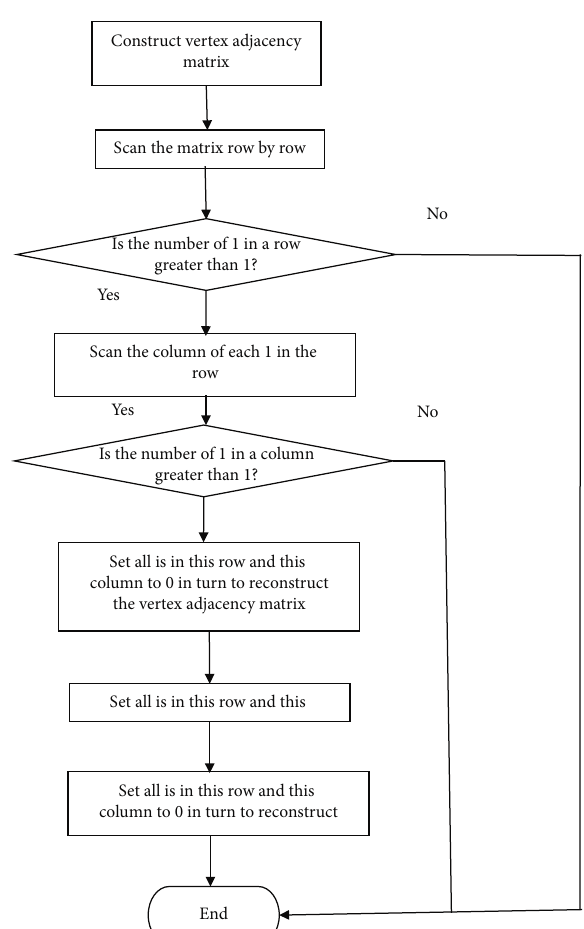
Figure 5: Flowchart of the simplification of the directionless two- part